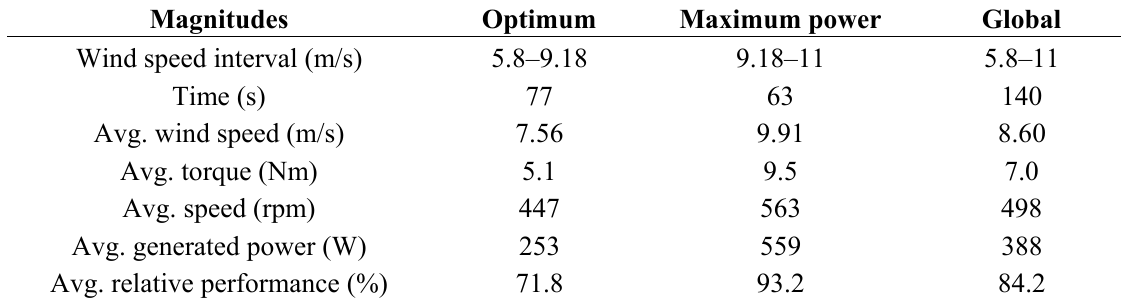
Table 2. First test averaged values for the two operational modes, and